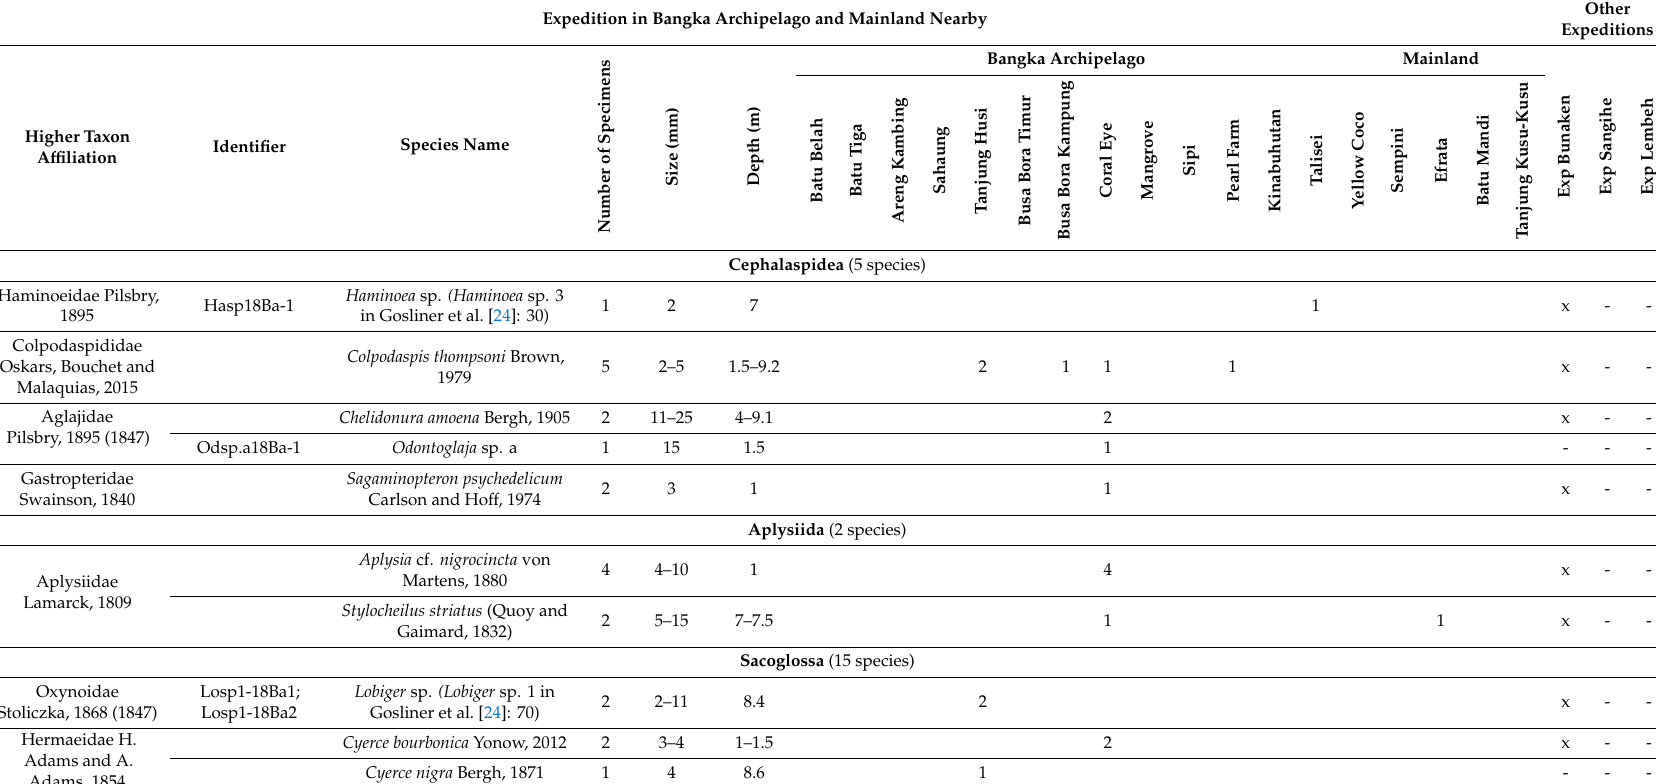
Table 2. List of species, specimen identifiers, and further metadata of the material; (*) indicate species that were identified only by photo-documentation. The last three columns indicate the number of specimens or occurrence of the respective species in other study areas nearby (information is taken from Eisenbarth et al. (2018) [16], Undap et al. (2019) [18], and Ompi et al. (2019) [17]: BNP, Lembeh Strait, and Sangihe